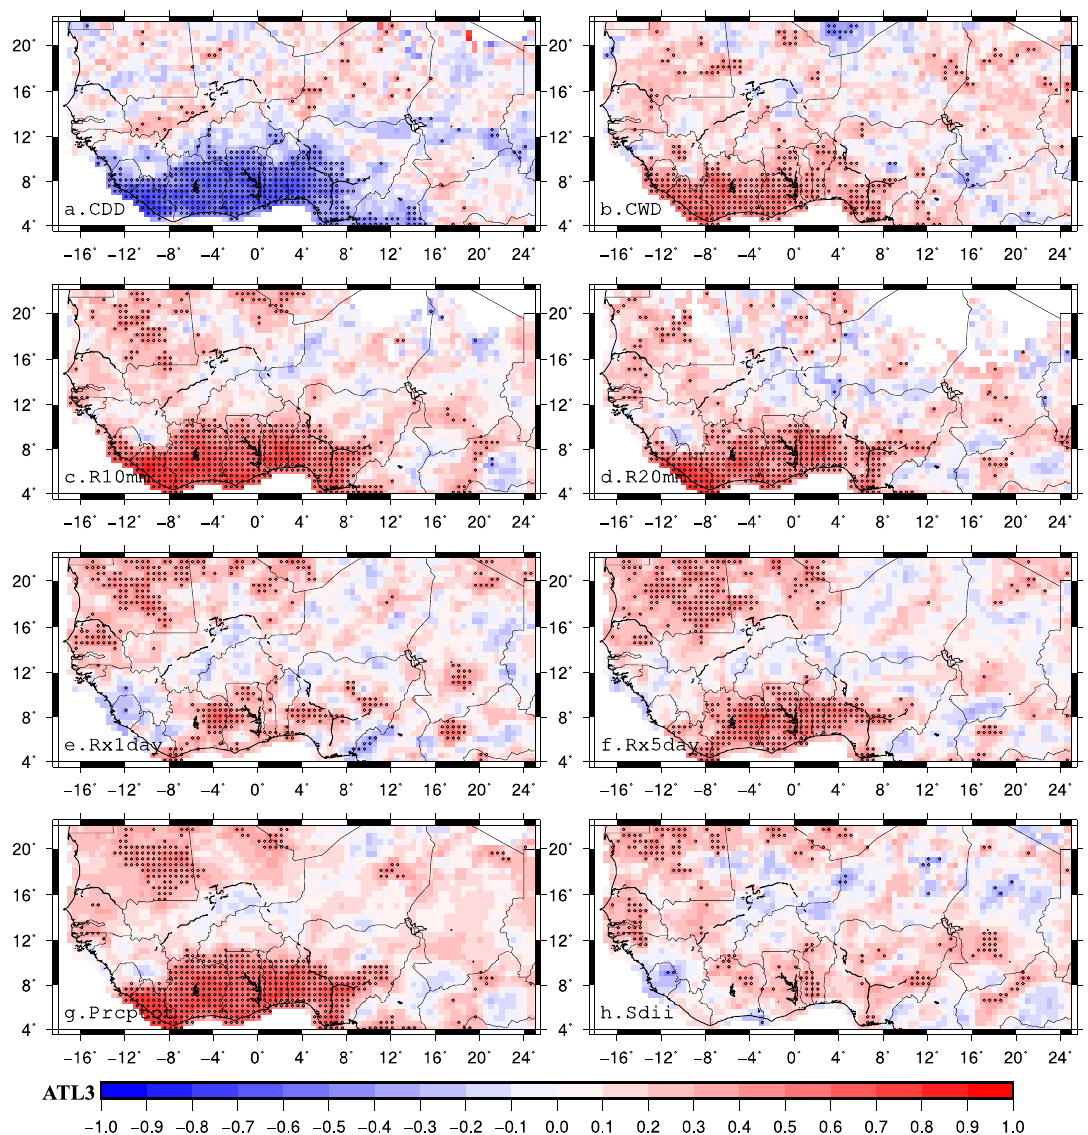
Figure 7. Correlation patterns between ATL3 and extreme precipitation indices. Tipping points represent significant correlation areas using EDOF . ( a ) CDD, ( b ) CWD, ( c ) R10mm, ( d ) R20mm, ( e ) Rx1day, ( f ) Rx5day, ( g ) Prcptot and ( h ) Sdii.